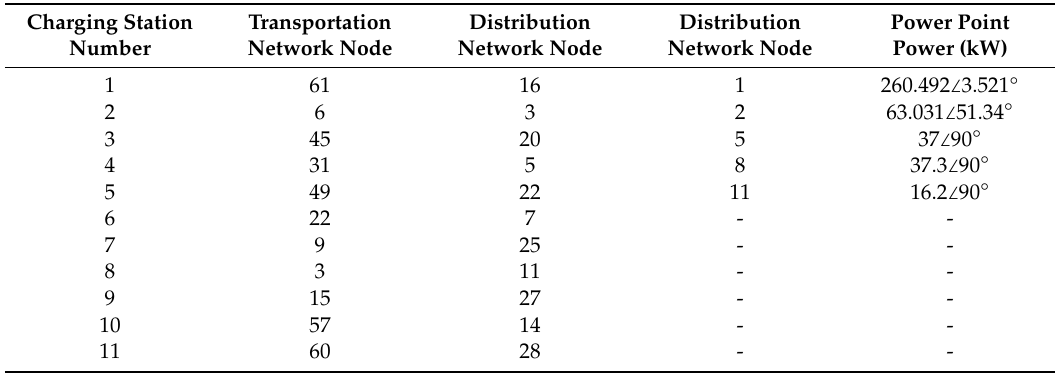
Table A2. Charging station number, 30-node distribution network node and transportation network node coupling correspondence table.